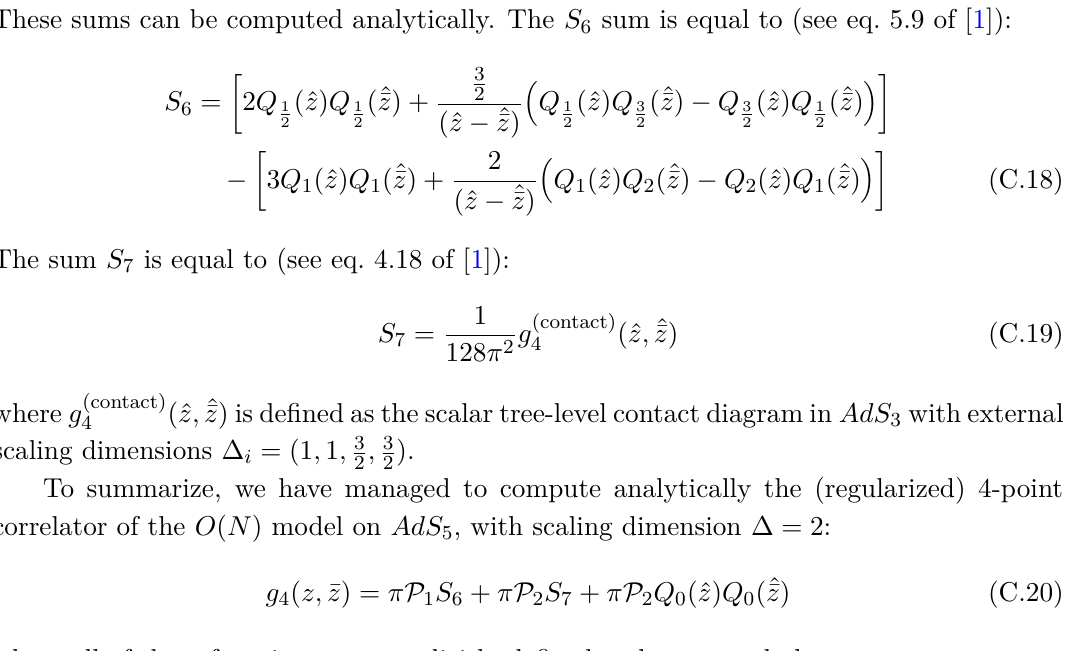
, discussed in section 2